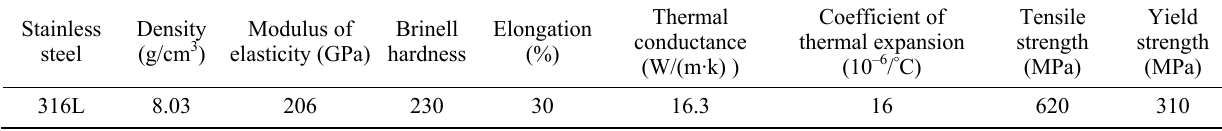
Table 3 Main performance parameters of